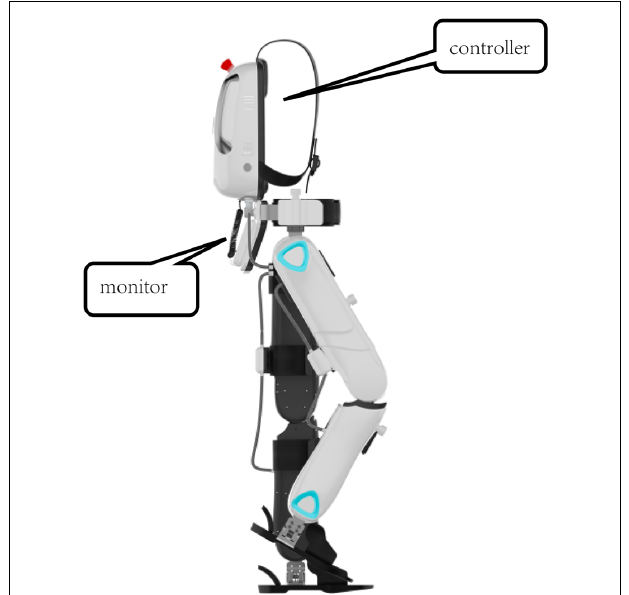
FIGURE 1 | The overall structure of BEAR-H1. The exoskeleton provides assistance with an impedance controller, where the assistance is bassed on the deviation of the joint to the reference trajectory. It is equipped with a gait monitoring and evaluation system, which enables physical therapists to monitor the patient’s motion on the screen in real-time.